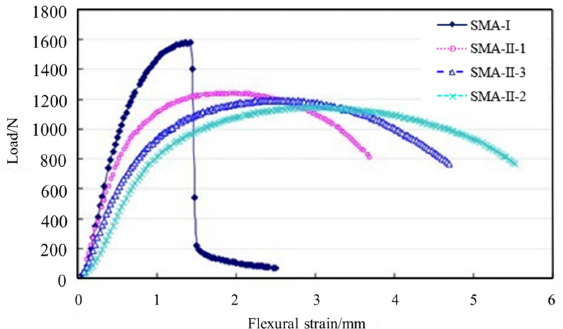
Figure 13. Relationship between load and flexural strain of low temperature bend test at −10 °C, at loading rate of 50 mm/min.